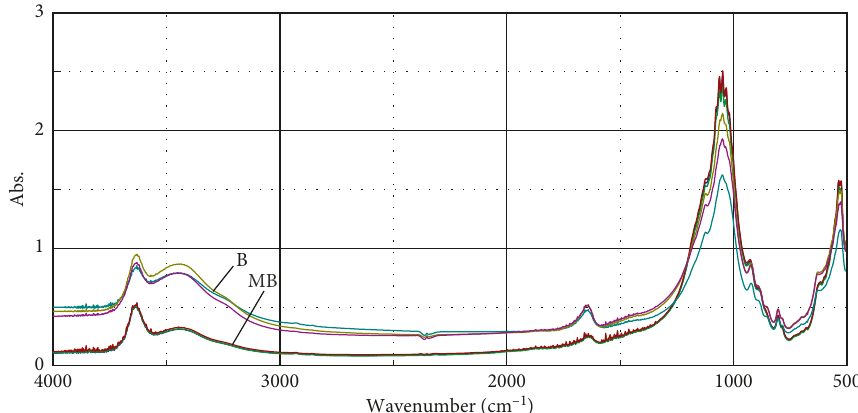
Figure 3: FT-IR spectra of purified bentonite (B) and mineralized bentonite (MB).